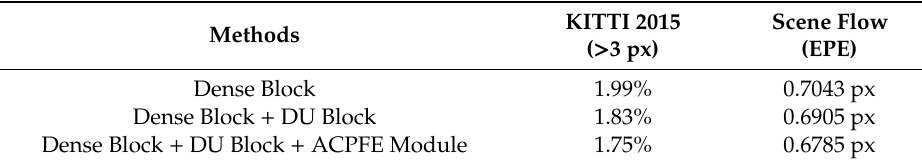
Table 1. Evaluation of MDA-Net with di ff erent